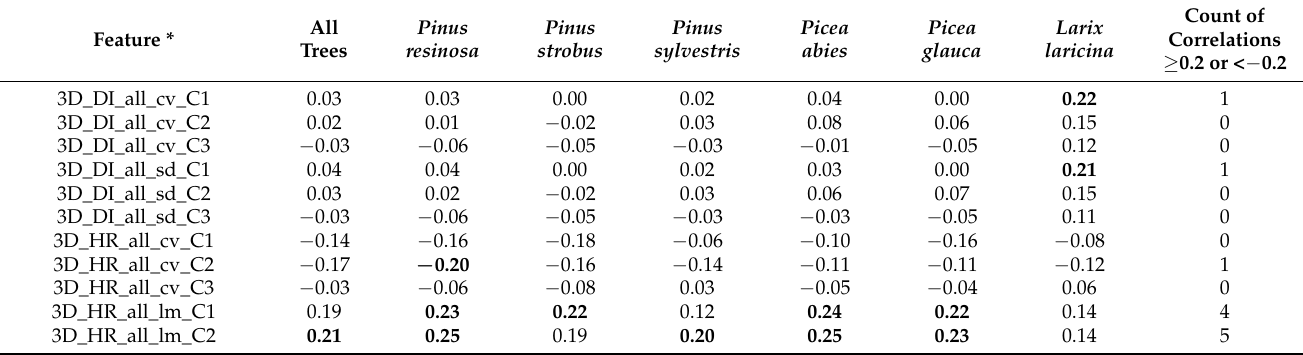
Table A1. Correlations ( r ) between 3D features and mean scan